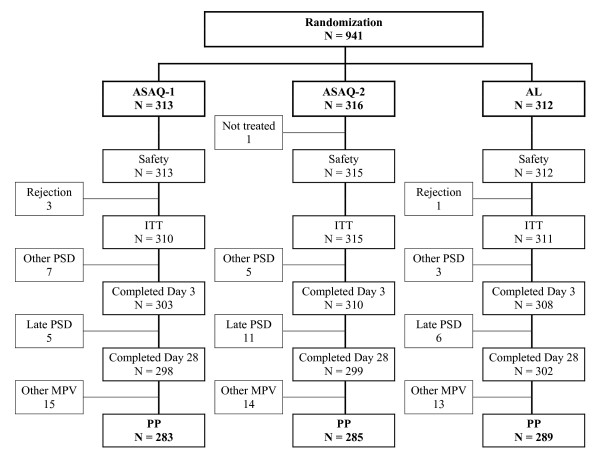
Patient flow through the study. AS: artesunate; AQ: amodiaquine; A: artemether; L: lumefantrine; ITT: intent to treat; PP: per protocol; MPV: major protocol violation; PSD: premature study discontinuation.